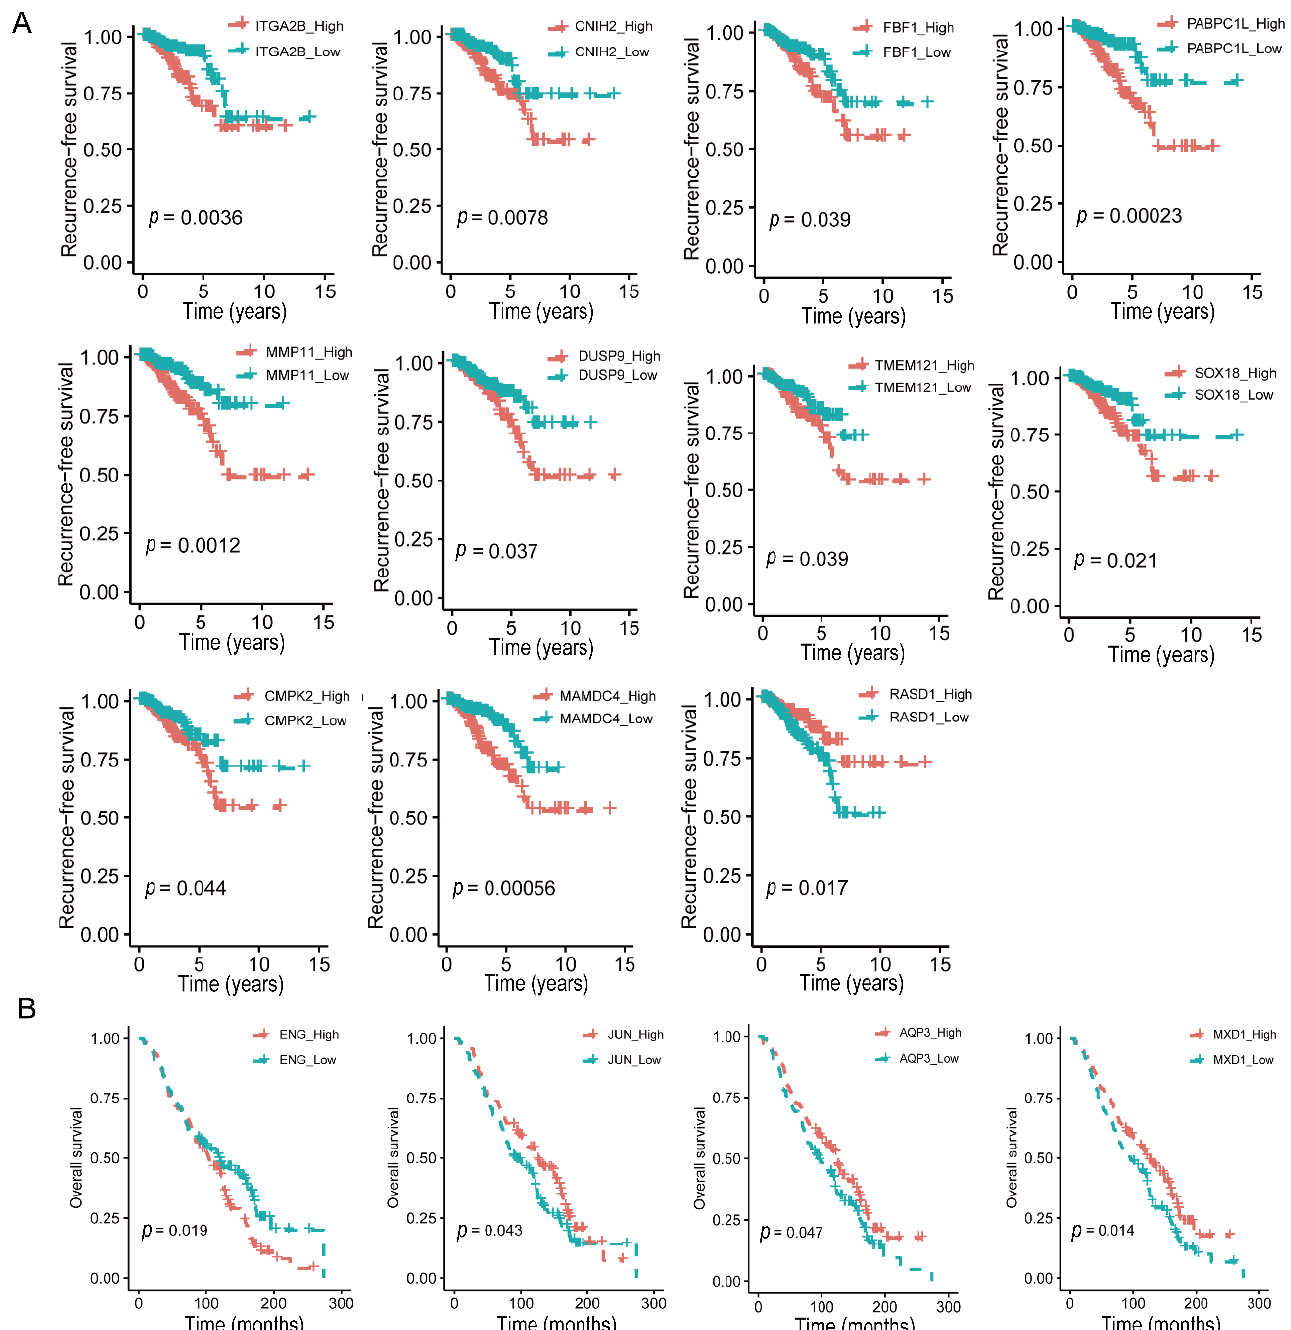
Figure 7. Altered expression of deslanoside-modulated genes correlates with recurrence-free survival (RFS) or overall survival (OS) in PCa patients. Kaplan-Meier analysis was used to determine RFS ( A ) and OS ( B ) in patients with higher and lower expression levels of a gene. Gene expression and survival information were retrieved from the TCGA database for DFS and the GSE16560 FOR OS. Genes correlated with RFS include ITG2B , CNIH2 , FBF1 , PABPC1L , MMP11 , DUSP9 , TMEM121 , SOX18 , CMPK2 , MAMDC4 , and RASD1 ; and those correlated with OS include ENG , JUN , AQP3 , and MXD1 . Table 1. Identification of genes and their association with recurrence-free survival (RFS) or overall survival (OS) in pros- tate cancer.